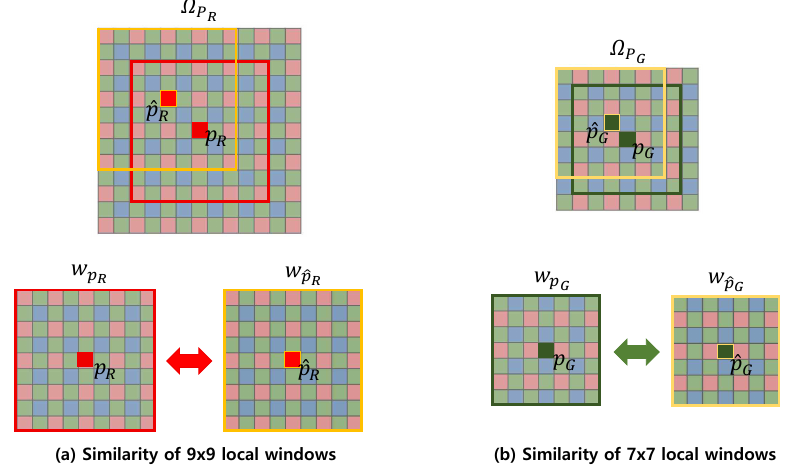
Figure 2. Measuring the local structure similarity using ( a ) 9 × 9 windows for R and B pixels and ( b ) 7 × 7 windows for G